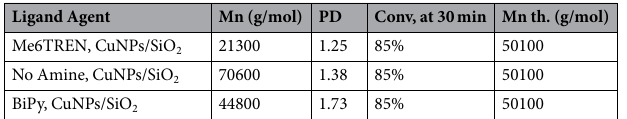
Table 4. GPC data for BA polymerization using CuNPs/SiO 2 and different ligand